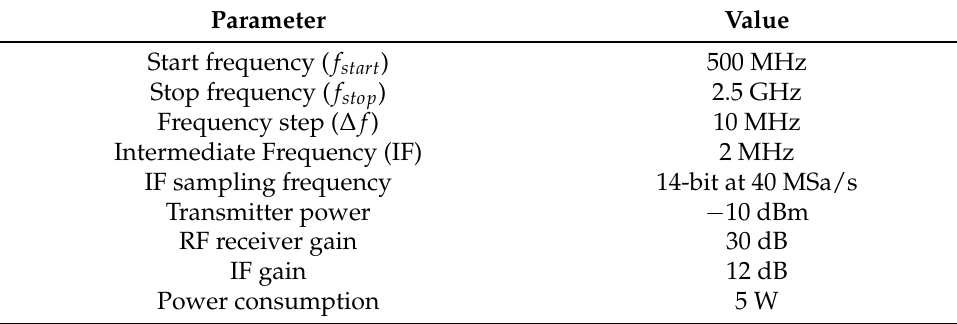
Table 1. Summary of the main SFCW radar with EC hardware